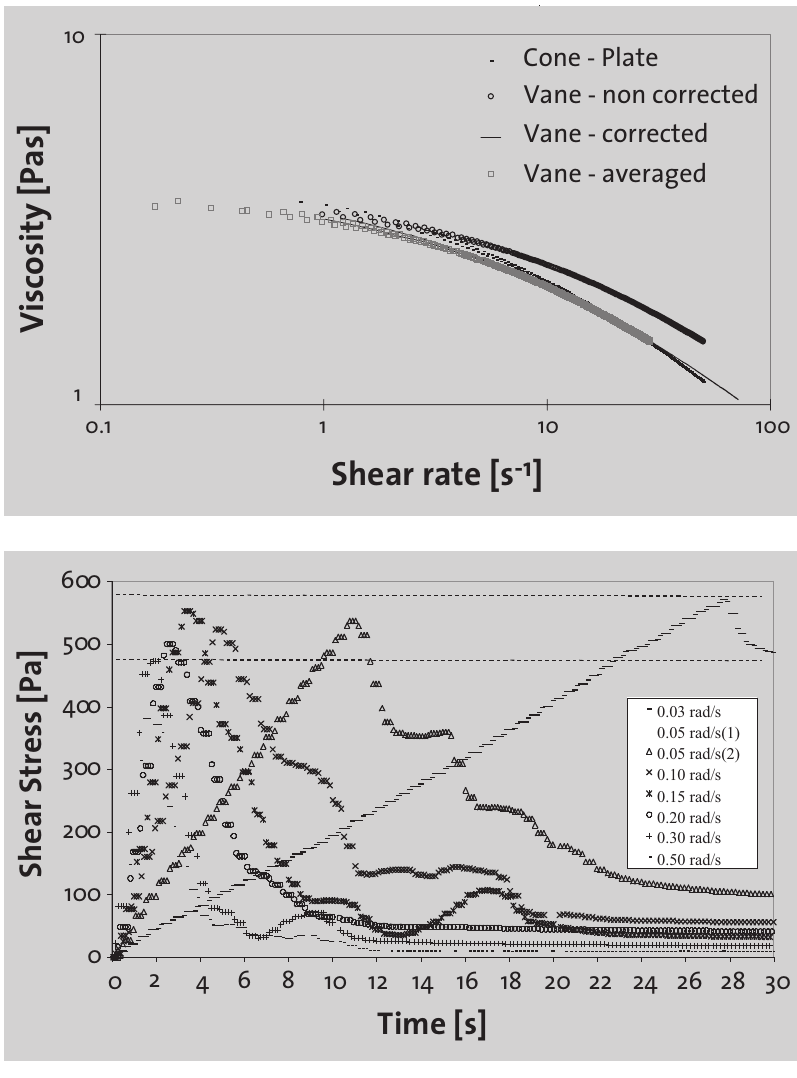
Figure 4 (above) : Flow curves for a non-Newtonian 15 g/kg “Tylose” solution. Vane measurements are corrected using Eq. 5 and 6. Figure 5 (below) : Yield stress determination of a 2.5 g/kg Kappa-carrageenan gel using maximum stress for a range of rotation rates. Each curve was obtained using a fresh sample (AR 1000 TA Instruments